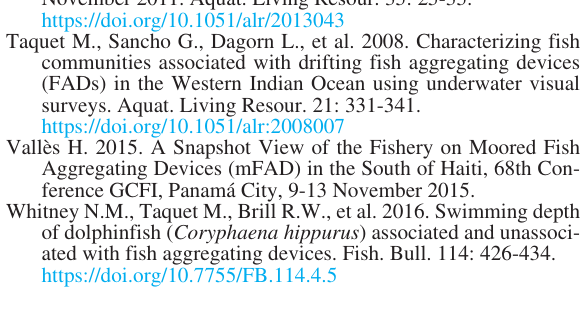
Table S1. – Camera type, power source and setup used in this study. Fig. S1. – A camera was redeployed to conduct a range test to de- termine approximately how far a vessel in an image was from the FAD. Image (1) is a vessel that is 70 metres from the FAD; Image (2) is the same vessel 132 m from the FAD. These photos were used to determine the proximity of vessels to the FADs. Fig. S2. – Clockwise from upper left: (1) Vessel #55 earliest buoy visit 0542; (2) Vessel #143 latest buoy visit 1823; (3) Yellow ar- rows indicate highest number of vessels present in single image; all were unclassifiable and designated as unknown; (4) tanker. Fig. S3. – Clockwise from upper left: (1) Vessel #89 known char- ter vessel trolling; (2) Vessel #132 likely recreational vessel trolling named “g_yacht_blue_pin_strips_dbl_window”; (3) Vessel #9 known commercial vessel trolling; (4) Vessel #23 likely recreational vessel drift fishing with handlines named “g_blank_boat”. Fig. S4. – Clockwise from upper left: (1) Vessel #69 likely recrea- tional spearfishermen with spears and floats visible; (2) Vessel #12 known commercial vessel with gaff in hand; (3) Vessel #19 likely recreational vessel jigging and drift fishing with sargassum present; (4) Unknown vessel trolling away from the buoy with a fish visible (it appears to be a dolphinfish) in the foreground. Fig. S5. – Clockwise from upper left: (1) Vessel #50 present in squall; this vessel was named “g_very_sm_lowris_centercons”; (2) Vessel #57 shown tying up to buoy F; (3) Example of image with vessel and birds blocking a portion of the field of view; (4) Example of image with vessel with a bird blocking a greater portion of the field of view. Fig. S6. – Clockwise from upper left: (1) Unknown vessel present with foggy lens and bird present; (2) A dolphinfish is present in the lower left portion of the image; (3) An unidentified tern bird with a fish in its beak; (4) An unidentified marine